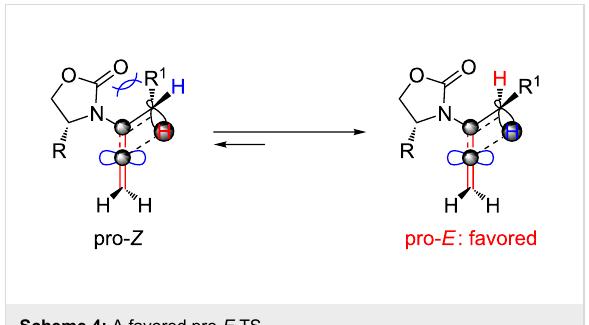
Scheme 4: A favored pro- E